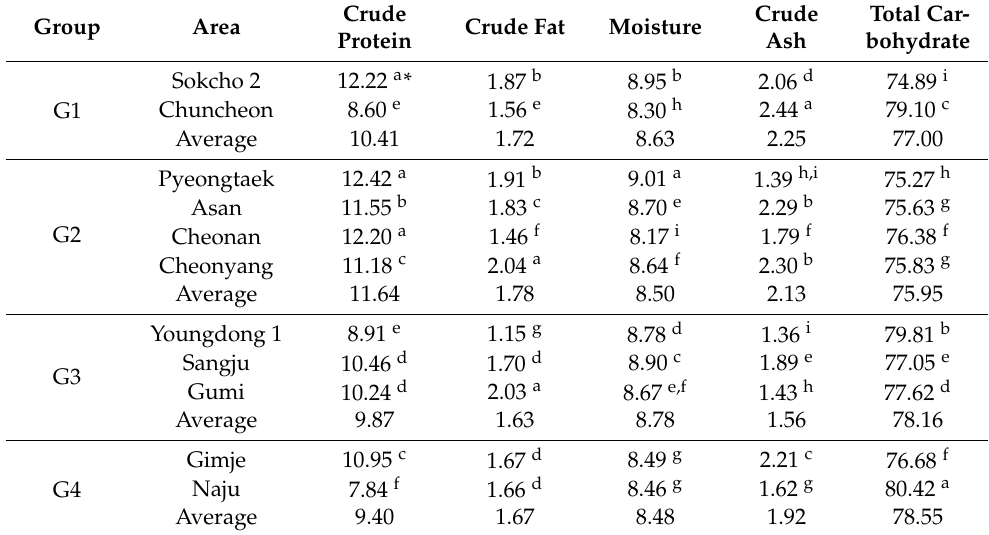
Crude Total Car- Ash bohydrate